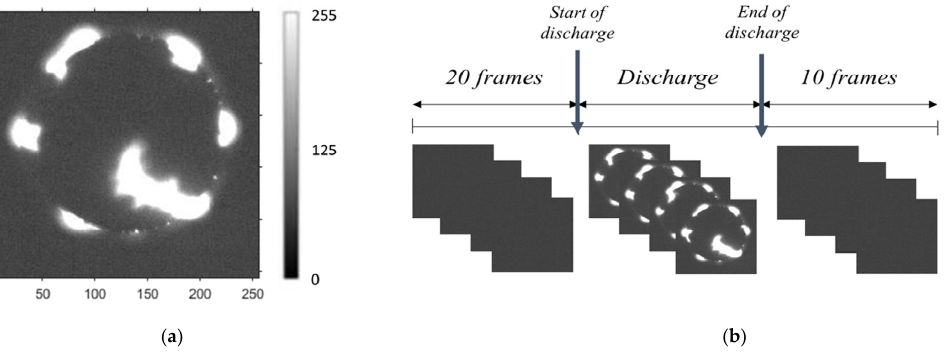
Figure 4. ( a ) Representation in MATLAB environment, in grey scale (0–255), of a frame acquired by the camera. ( b ) Frame selection process performed to identify the beginning and termination of the discharge event.